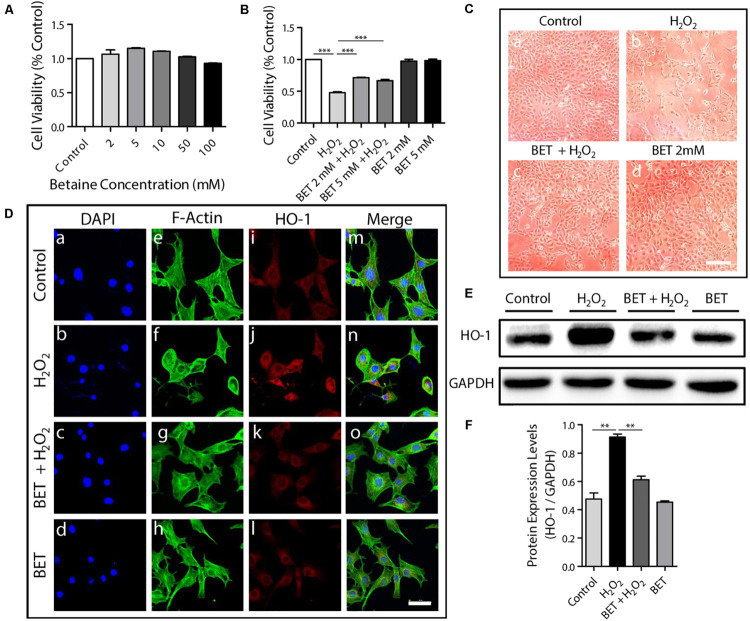
The cyto-compatibility and anti-oxidative stress property of betaine in vitro. (A) NIH 3T3 cell viability after 12 h’ betaine treatment of different concentration, n = 6. (B) NIH 3T3 cell viability after 4 h’ H2O2 (50 μM) exposure with or without pretreatment of 5 h’ betaine (2 mM and 5 mM), n = 6. (C) NIH 3T3 cell morphology observed by optical telescope: (a) control (b) after 4 h’ H2O2 (50 μM) exposure (c) after 4 h’ H2O2 (50 μM) exposure with pretreatment of 5 h’ betaine (2 mM). Scale bar: 200 μm. (d) after 5 h’ betaine treatment. (D) HO-1 immunofluorescence staining of NIH 3T3 cells after 4 h’ H2O2 (50 μM) exposure with or without pretreatment of 5 h’ betaine (2 mM). The figures share the same scale bar of 50 μm. (E,F) HO-1 expression analysis by Western blot, n = 3. NIH 3T3 cells were treated as described in (D). BET: betaine. Statistical differences were performed using ANOVA. ***p < 0.001, **p < 0.01.